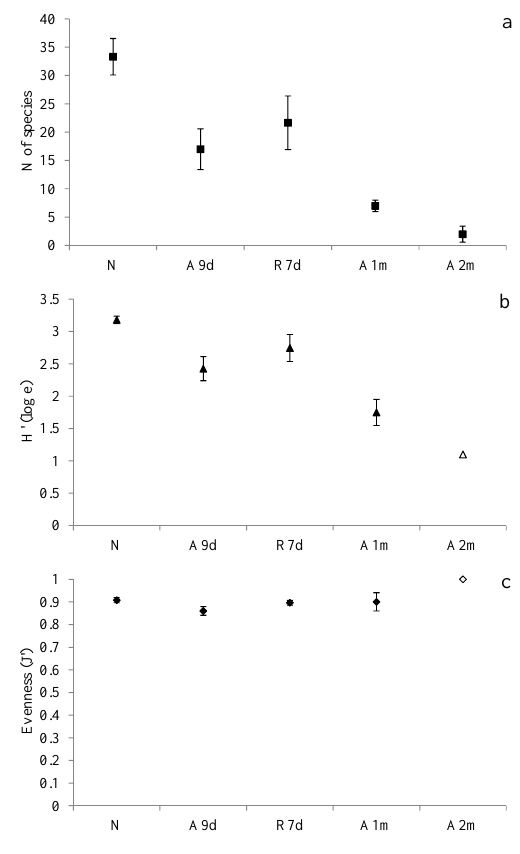
Fig. 3. Diversity indices: (a) species richness; (b) Shannon diversity index (A2m; calculated from one replicate containing 3 specimens, as in the other replicate only a single individual was present); (c) Pielou’s evenness index (A2m; same as for Shannon diversity in- dex). Depth was pooled, copepodites excluded from calculations. N = normoxia, A = anoxia, R = recovery, duration of treatment: 7days, 9days, 1month, 2months.